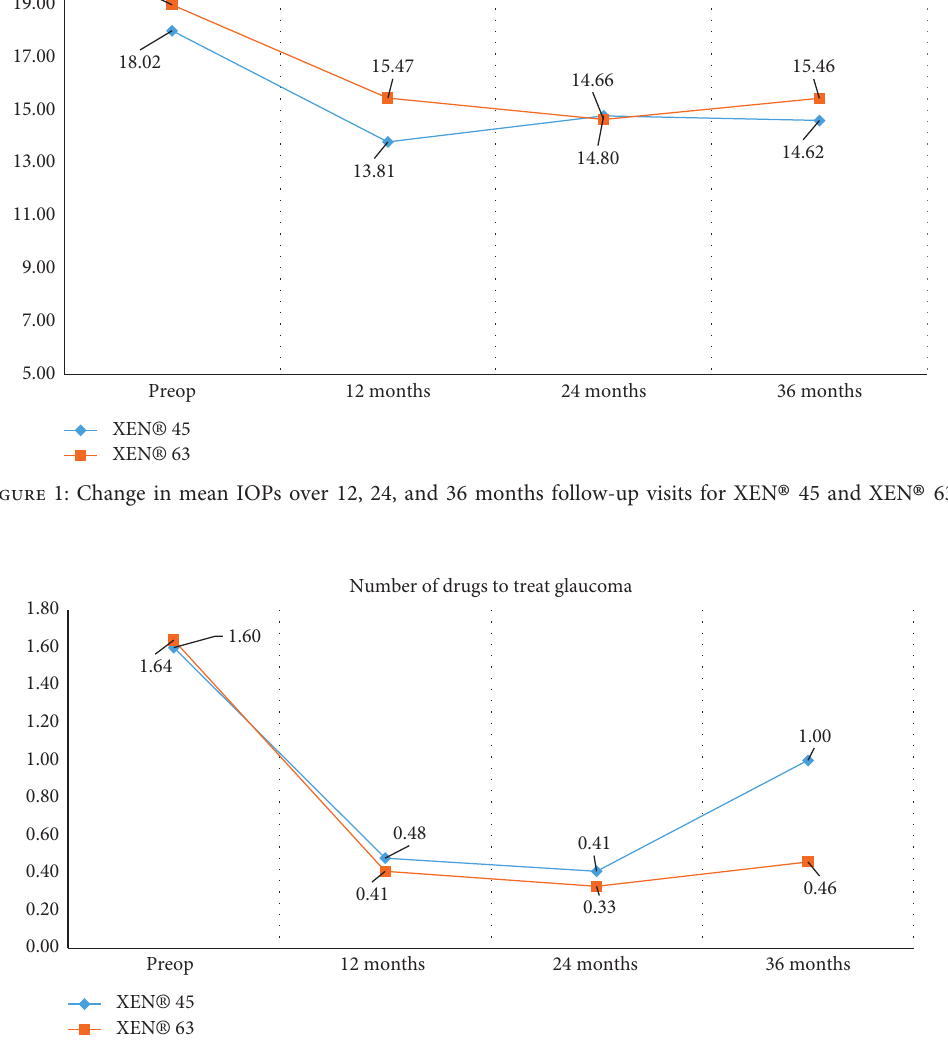
Figure 2: Change in number of IOP-lowering medications required by the patient over 12, 24, and 36 months follow-up visits XEN ® 45 and XEN ® 63. Table 3: Complications reported during the